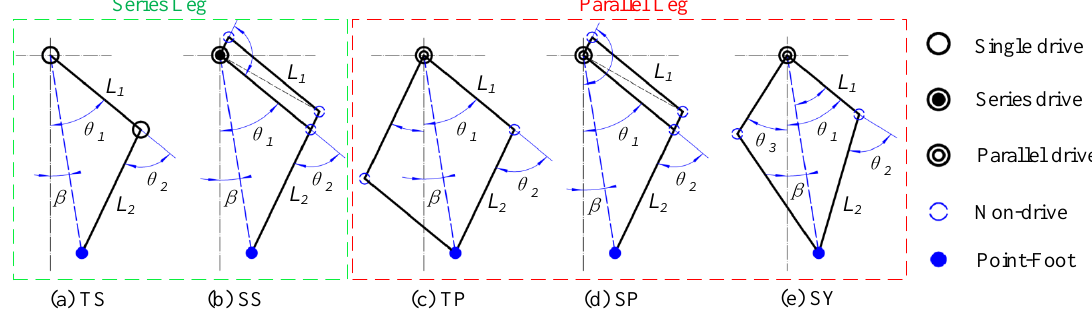
Figure 1. Different leg structures. ( a ) Traditional series (TS), ( b ) special series (SS), ( c ) traditional parallel (TP), ( d ) special parallel (SP) and ( e ) symmetrical (SY). The black hollow circle represents a single drive, the black circle containing a solid point represents two series drives oriented along the same axis, the black circle containing a hollow circle represents two parallel drives along the same axis, the blue hollow circle represents no drive and the blue solid point represents the